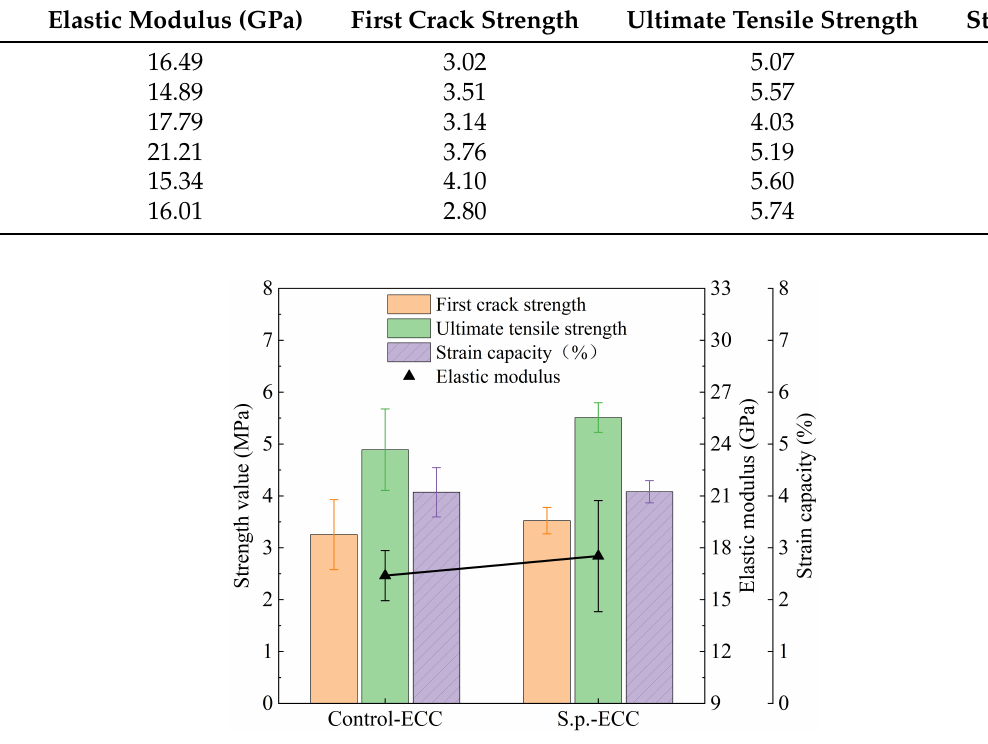
Figure 12. Comparison of the properties of ECC tensile specimens. Table 6. Crack statistics of ECC tensile specimens.